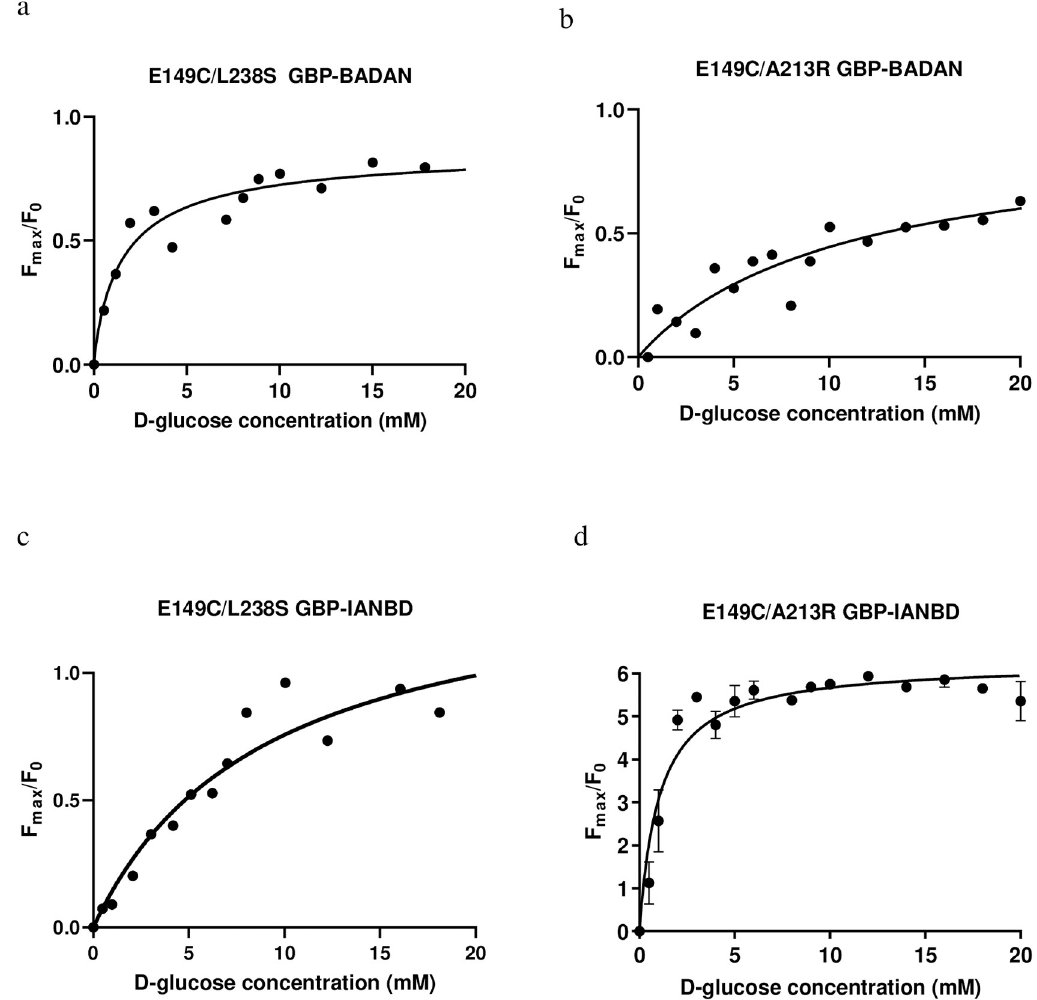
Fig 2. Fmax/F0 D-glucose concentration response curves for each of the dual mutation GBPs. a. E149C/L238S and b. E149C/ A213R labelled with BADAN, c. E149C/L238S and d. E149C/A213R labelled with IANBD. Curves were fitted using the one site- specific binding with Hill slope formulae in GraphPad